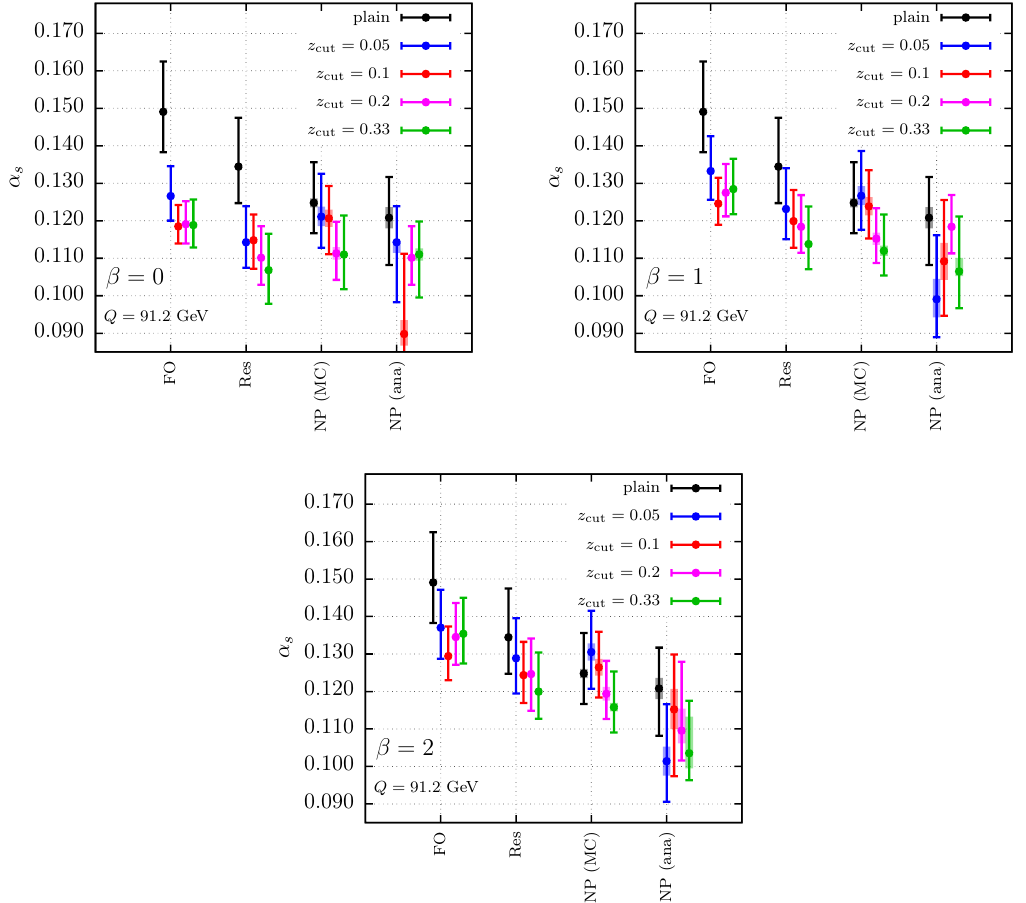
Figure 6. Results for (cid:12)ts of (cid:11) s ( m Z ) to Monte-Carlo pseudo data using theoretical predictions at di(cid:11)erent levels: FO for NLO, Res for NLO+NLL and NP for the inclusion of non-perturbative e(cid:11)ects. The non-perturbative e(cid:11)ects are modelled based on either the Monte-Carlo based hadron- to-parton level ratios (NP (MC)) or an analytical model with a single parameter (cid:10) (NP (ana)). The bands indicate the total uncertainty, the shaded region displays the hadronisation-related